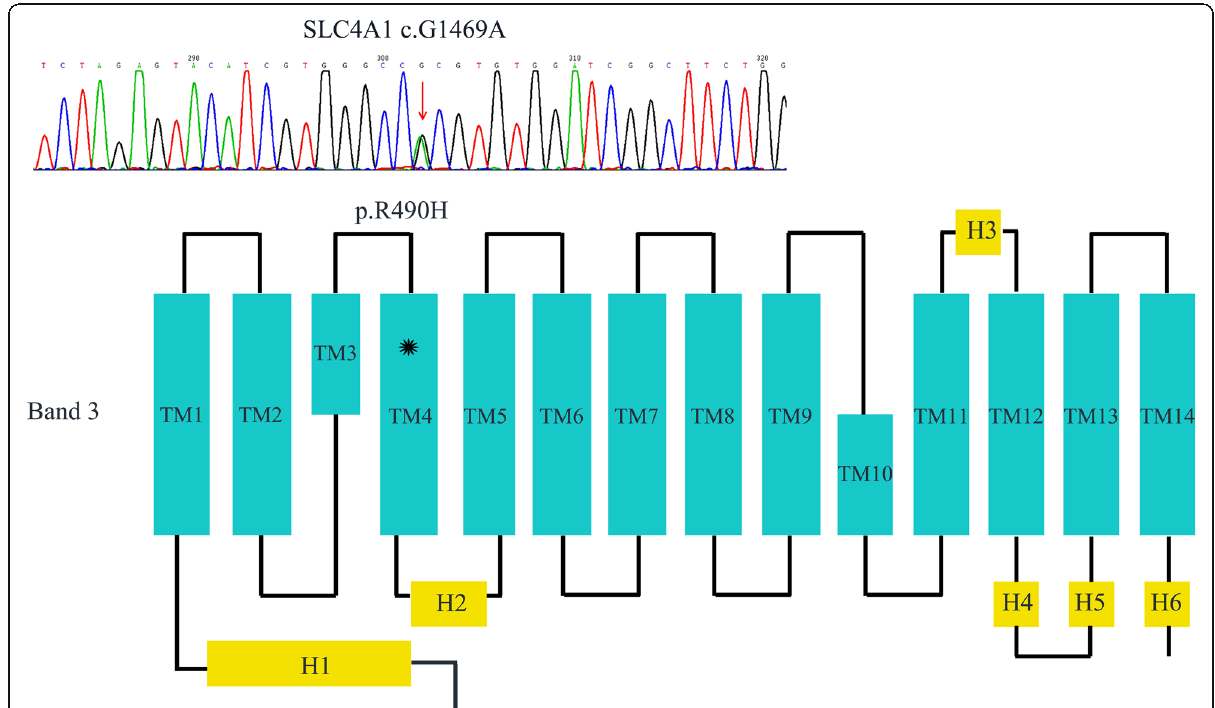
Fig. 3 S Sanger sequencing of the pathogenic SLC4A1 c.G1469A mutation in proband W and the localization of the mutation in schematic diagram of band 3. A heterozygous c.G1469A (p.R490H) mutation in SLC4A1 gene, which encodes band 3, was identified in proband W. Band 3 consists of 14 transmembrane (TM) segments and short helical (H) segments linking TM segments. The missense R490H mutation was located on TM4. The red arrow indicates G1469A mutation detected in Sanger sequencing. The asterisk indicates the position of R490H mutation in band 3. SLC4A1 , solute carrier family 4, anion exchanger, member